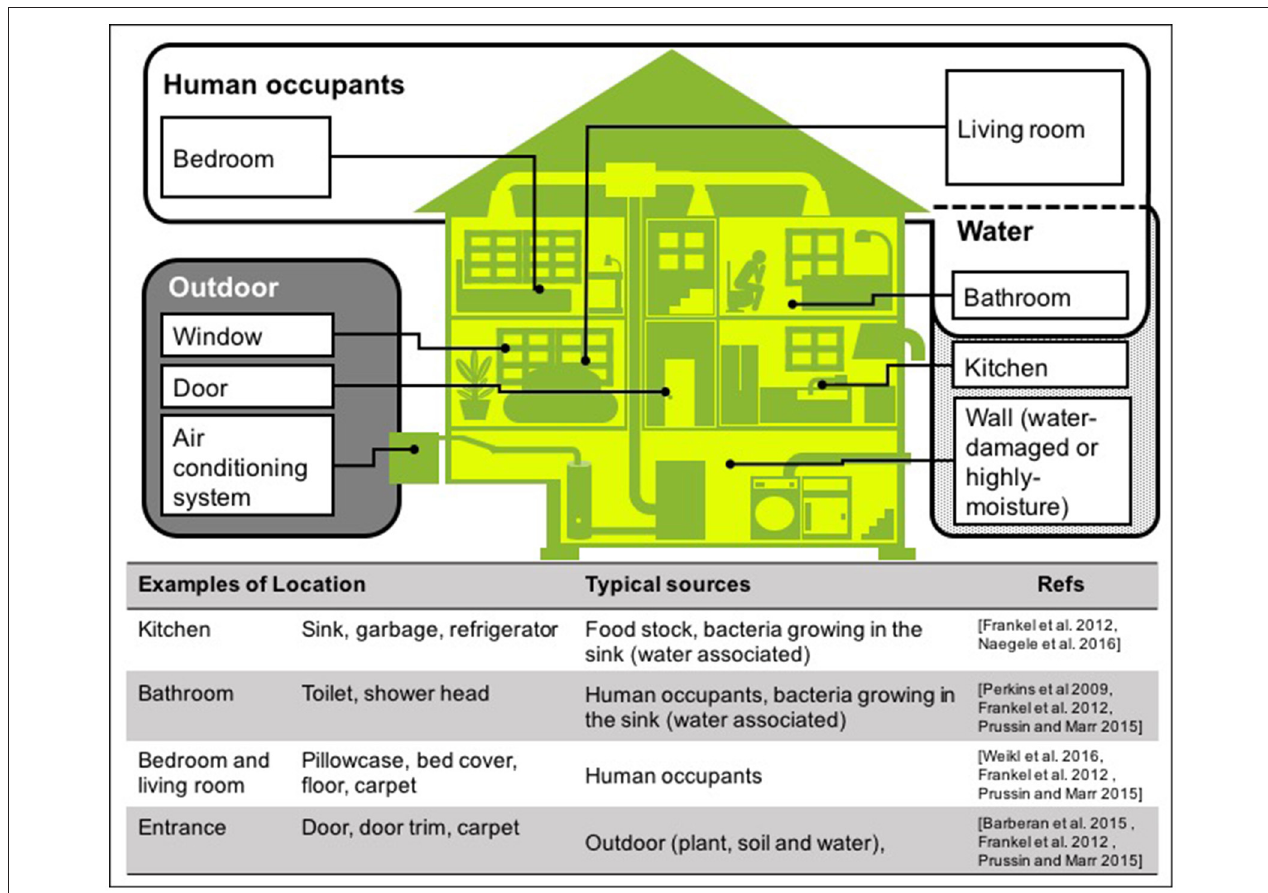
FIGURE 3 | Typical sources of airborne bacteria in a house. Three sources are shown: human occupants (white area), water (dotted area), and outdoors (gray area). Note that these are the groups we have used in this room, but other studies have presented alternatives (Dunn et al., 2013; Prussin and Marr, 2015; Sun et al., 2016).